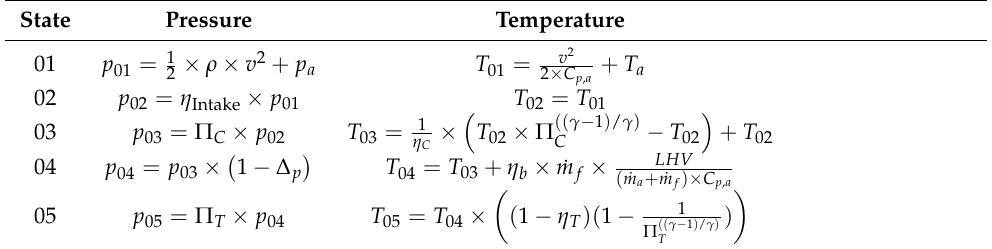
Table 3. Summary of the equations for pressure and temperature at each state of the turboshaft.